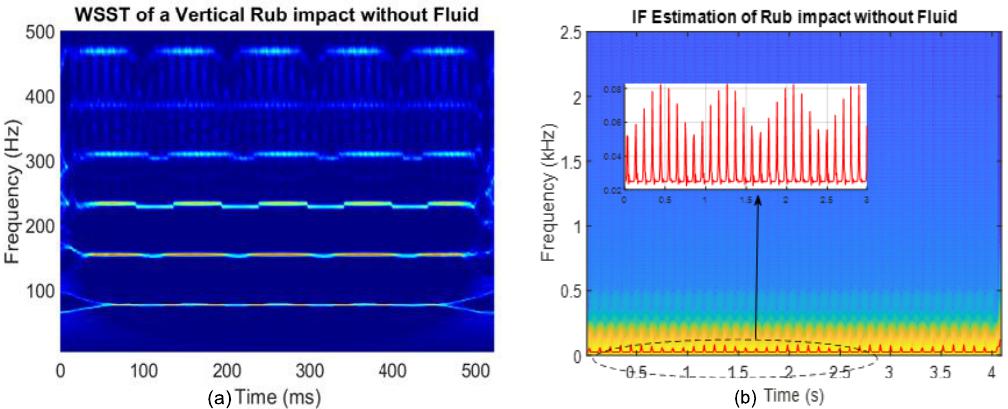
Figure 19. Time – frequency map of imbalanced rotor-casing rub; ( a ) NWSST response; ( b ) IF re- sponse .